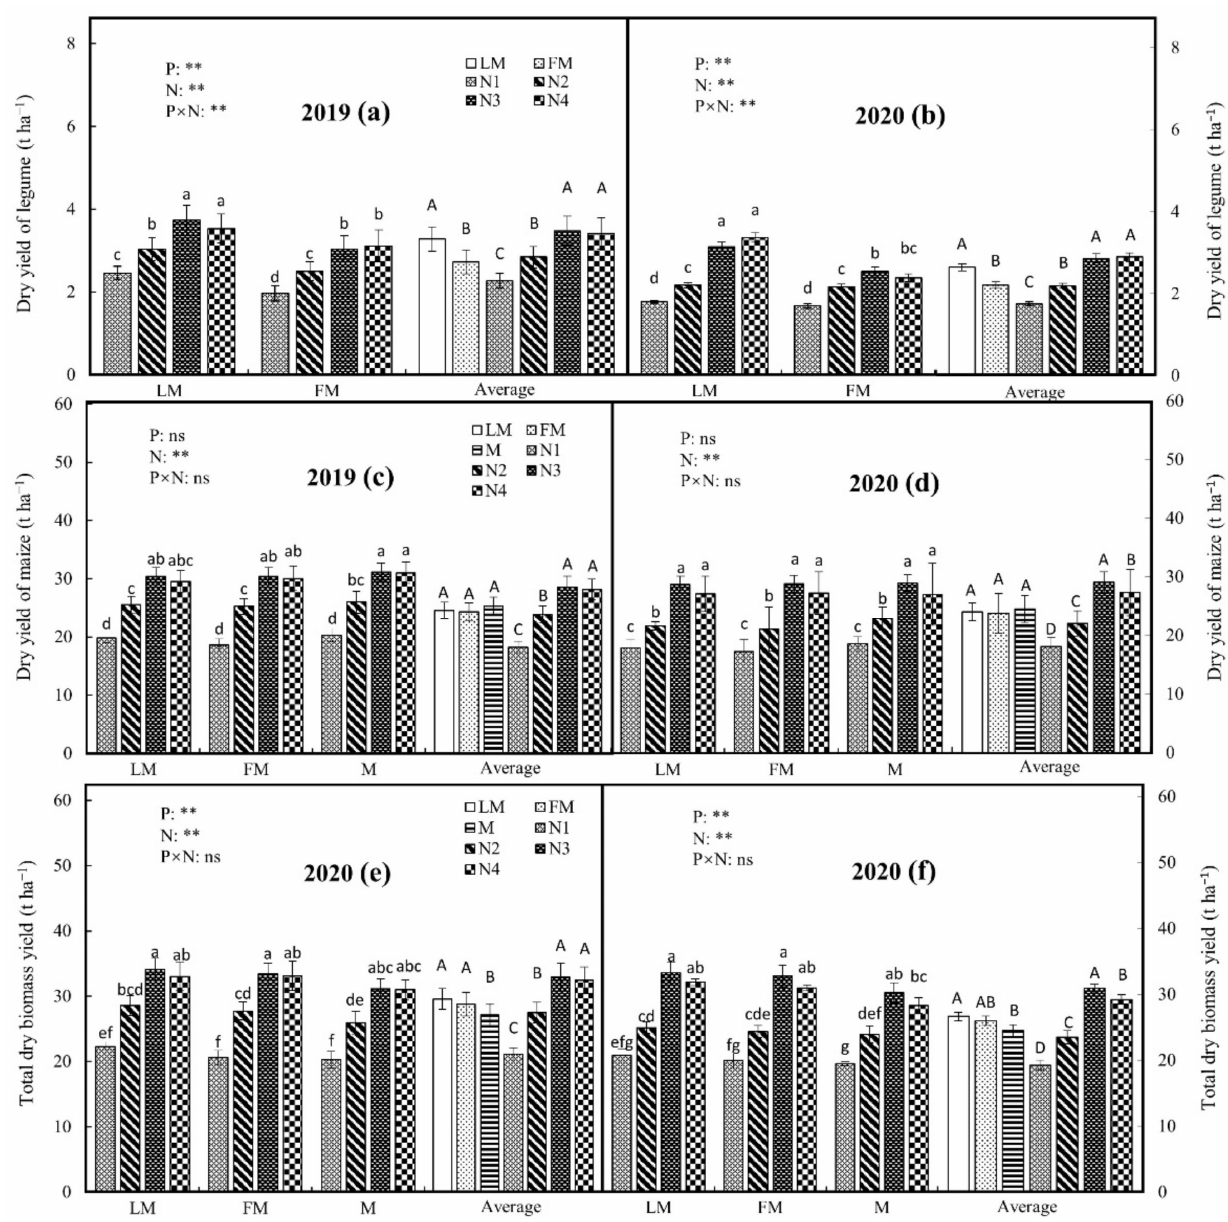
Figure 4. Dry yield of legume, maize, and intercropping systems under different treatments in 2019 and 2020. Note: ( a ), fresh yield of legume in 2019; ( b ), fresh yield of legume in 2020; ( c ), fresh yield of maize in 2019; ( d ), fresh yield of maize in 2020; ( e ), total fresh biomass yield in 2019; ( f ), total fresh biomass yield in 2020. M, silage maize monoculture; FM, intercropping of fodder soybean and silage maize; LM, intercropping of Dolichos lablab and silage maize; N1, 0 kg ha − 1 N; N2, 120 kg ha − 1 N; N3, 240 kg ha − 1 N; N4, 360 kg ha − 1 N. P, N, and P × N represents planting patterns, N application, and interaction between them, respectively; ** p < 0.01; ns, no significant difference. Different lowercase letters in the same series indicate significant differences among different treatments for the same forage ( p < 0.05). The different uppercase letters in the same series indicate significant differences among different levels of factors for the same forage ( p <